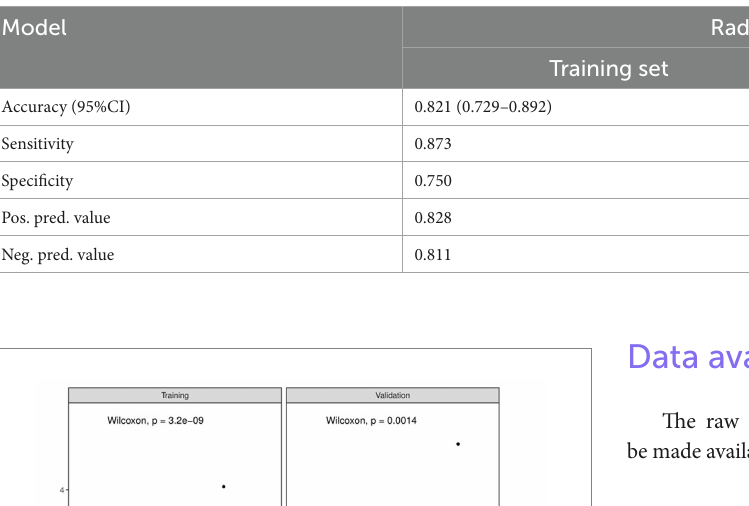
TABLE 4 Predictive performance of radiomics signature.